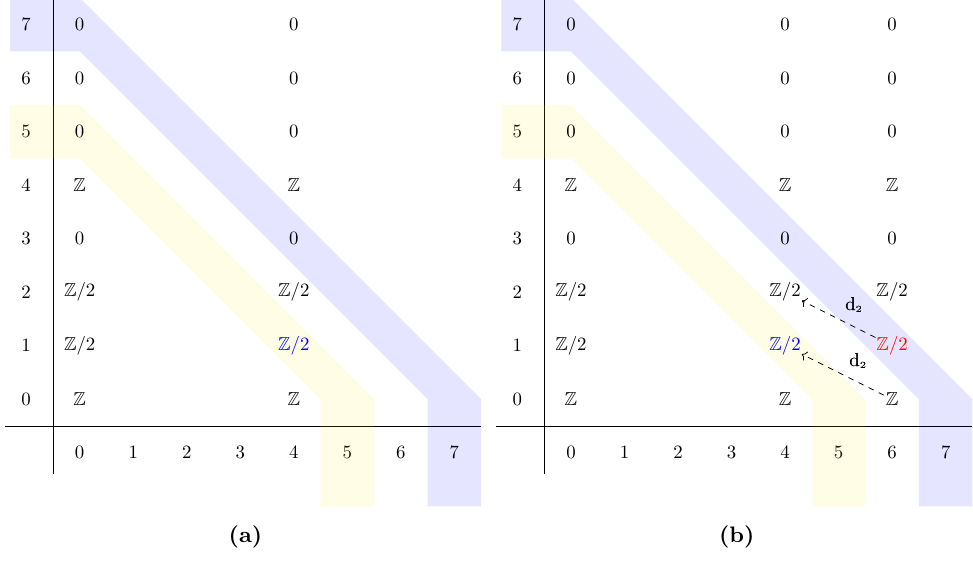
Figure 4. The second page of the AHSS for (a) Ω Spin • ( BSU (2)) and (b) Ω Spin • ( BSU (3))